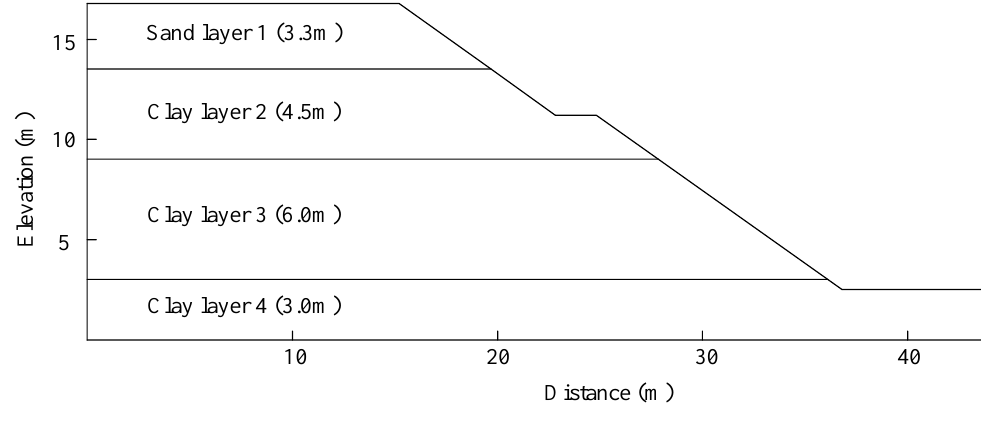
Figure 16. Chicago Congress Street cut slope. Table 6. Statistics of soil parameters of the Chicago Congress Street cut slope.